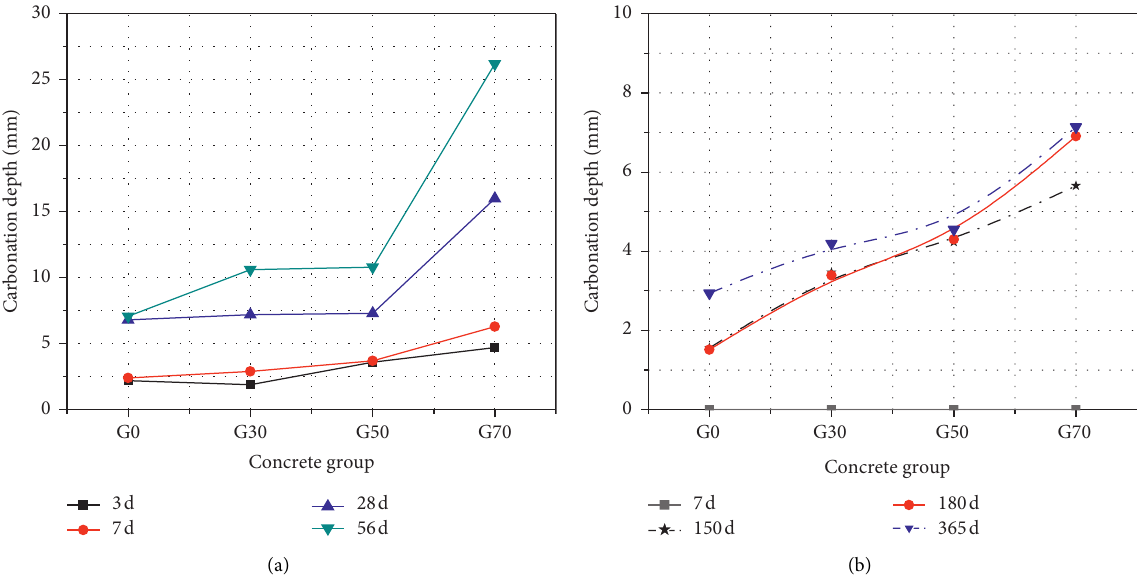
Figure 6: Influence of GGBS cement on carbonation resistance of concrete exposed to (a) accelerated carbonation and (b) natural